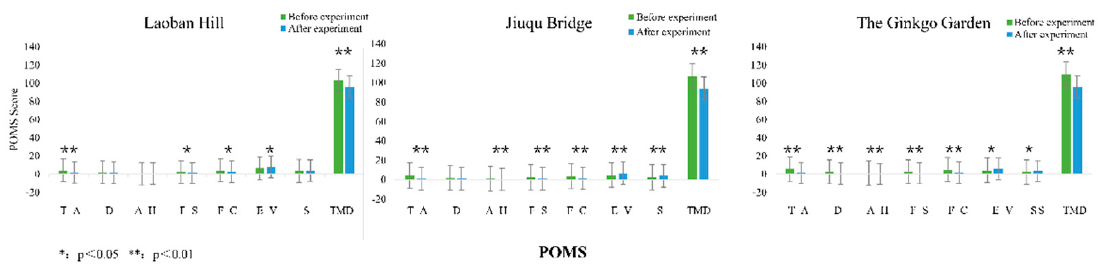
Figure 4. POMS Scale.